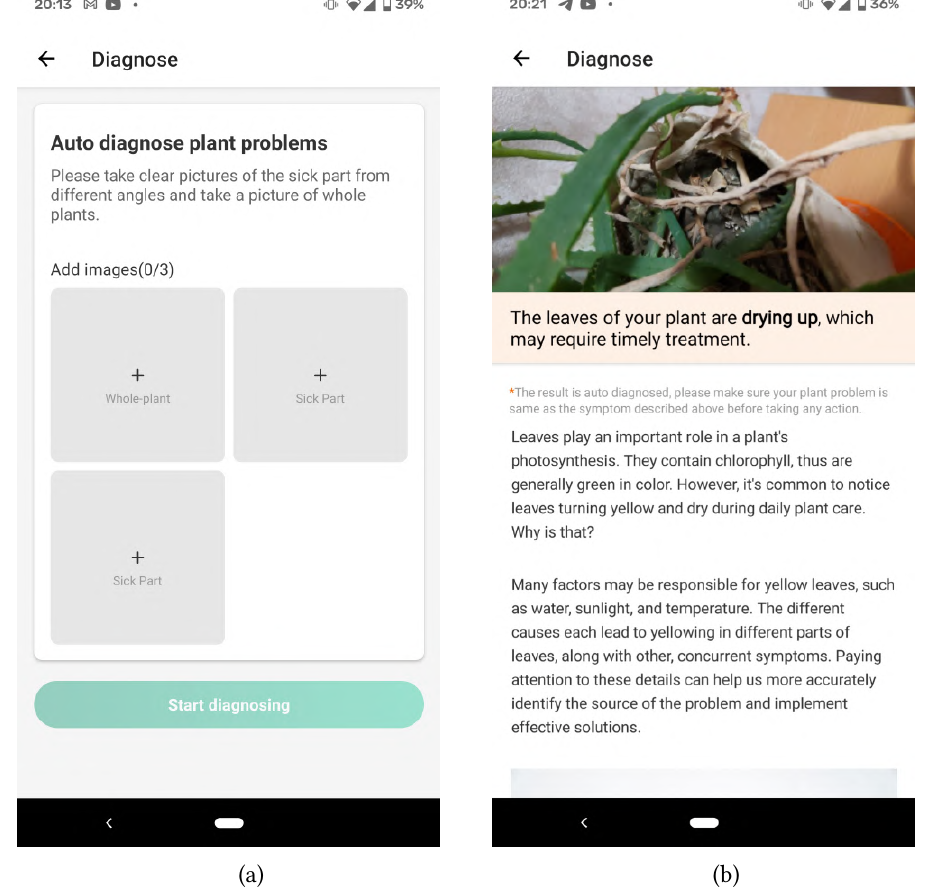
Figure 5: PictureThis’ plant’s auto diagnose on pests and diseases function: photo input interface (a) and the result of the analysis